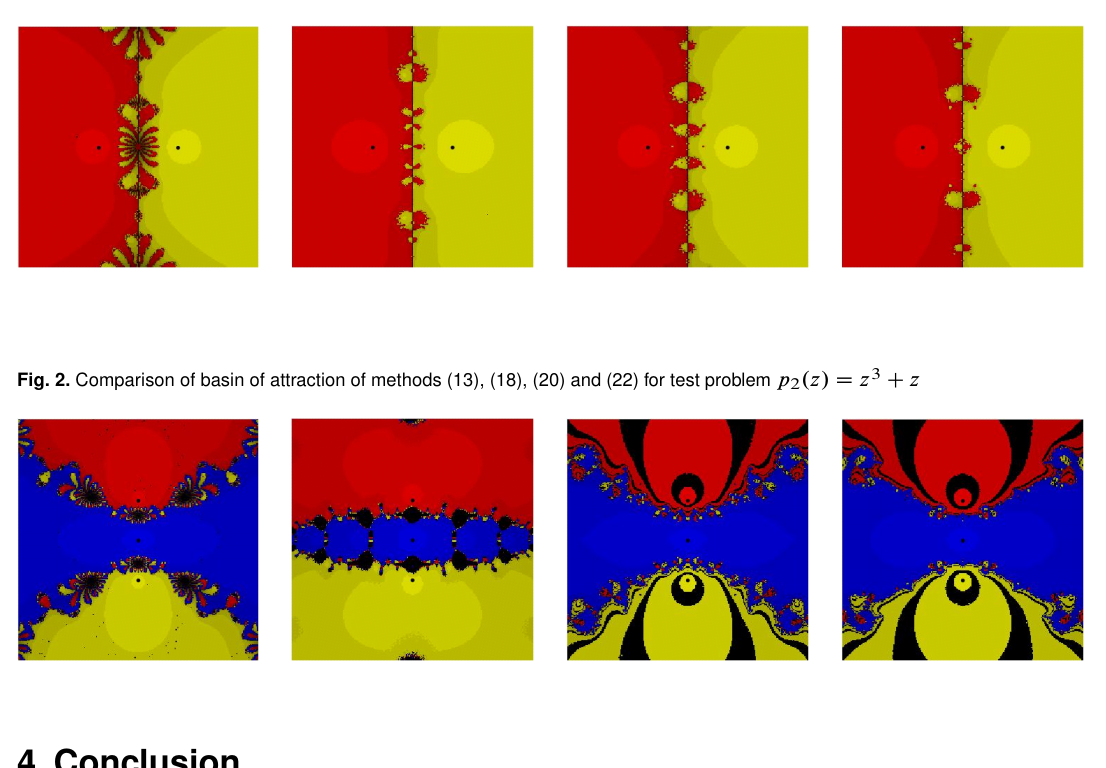
Fig. 1. Comparison of basin of attraction of methods (13), (18), (20) and (22) for test problem p 1 .z/ D z 2 (cid:0) 1